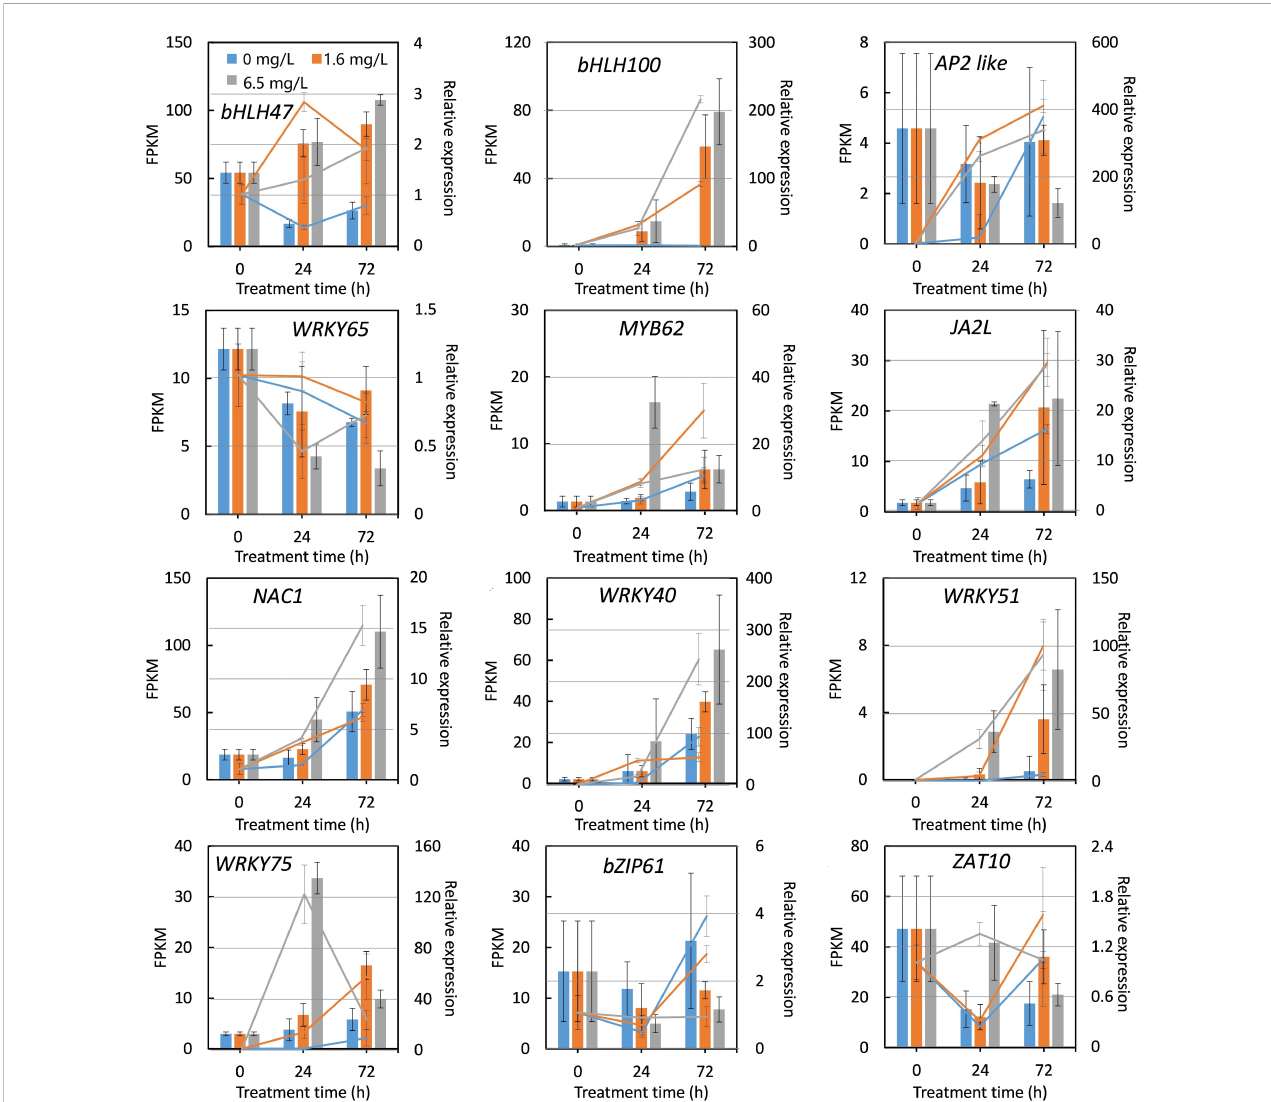
FIGURE 7 Quantitative real-time PCR (qRT-PCR) veri fi cation of the expression of 12 DEGs selected from RNA sequencing under Cd stress. The X-axis represents treatment time. The Y-axis on the left represents the expression level of speci fi c gene obtained from RNA-seq (histogram), and on the right, from qRT- PCR analysis (line chart). Each value is presented as means ± standard error from three repeats. Standard errors are indicated in fi gures using the